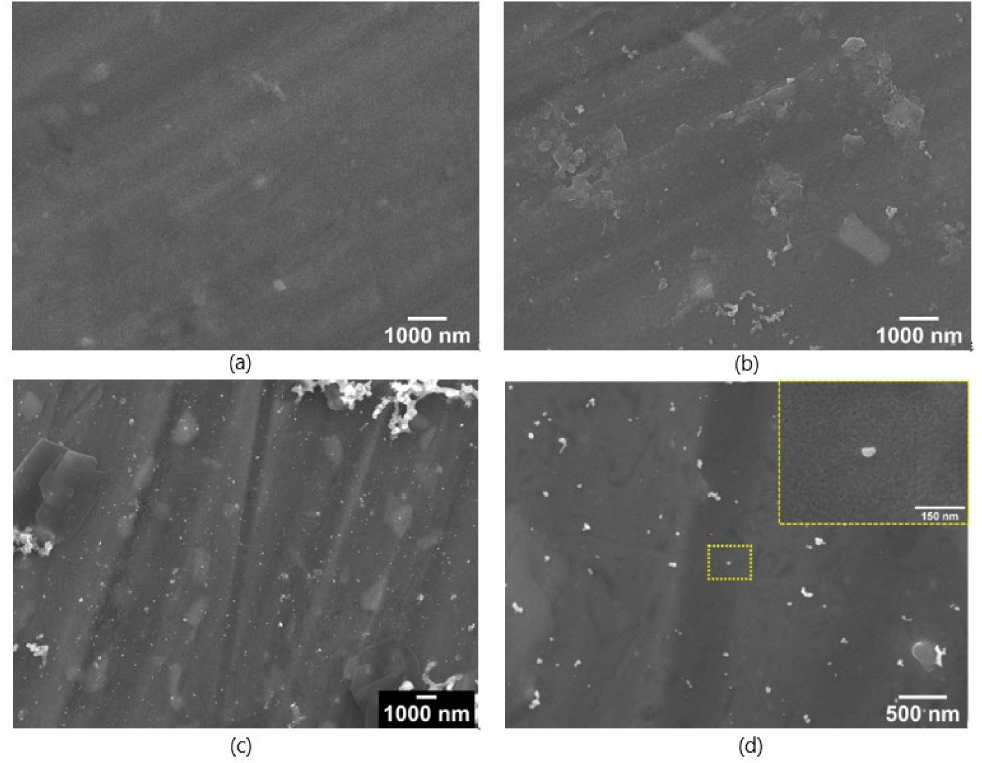
Figure 5. SEM image of a cleaned aluminium plate ( a ), a substrate coated with a solution of 4% TTIP calcinated to a TiO 2 -coating at 600 ◦ C for 5 h ( b ) and coated with AuNPs. ( c ) at 5000 × magnification. Additionaly more detailed SEM images from 25,000 × magnification, and the inlet represents a SEM image with a 100,000 × magnification are also displayed ( d ). WD 6 mm and 15 kV acceleration